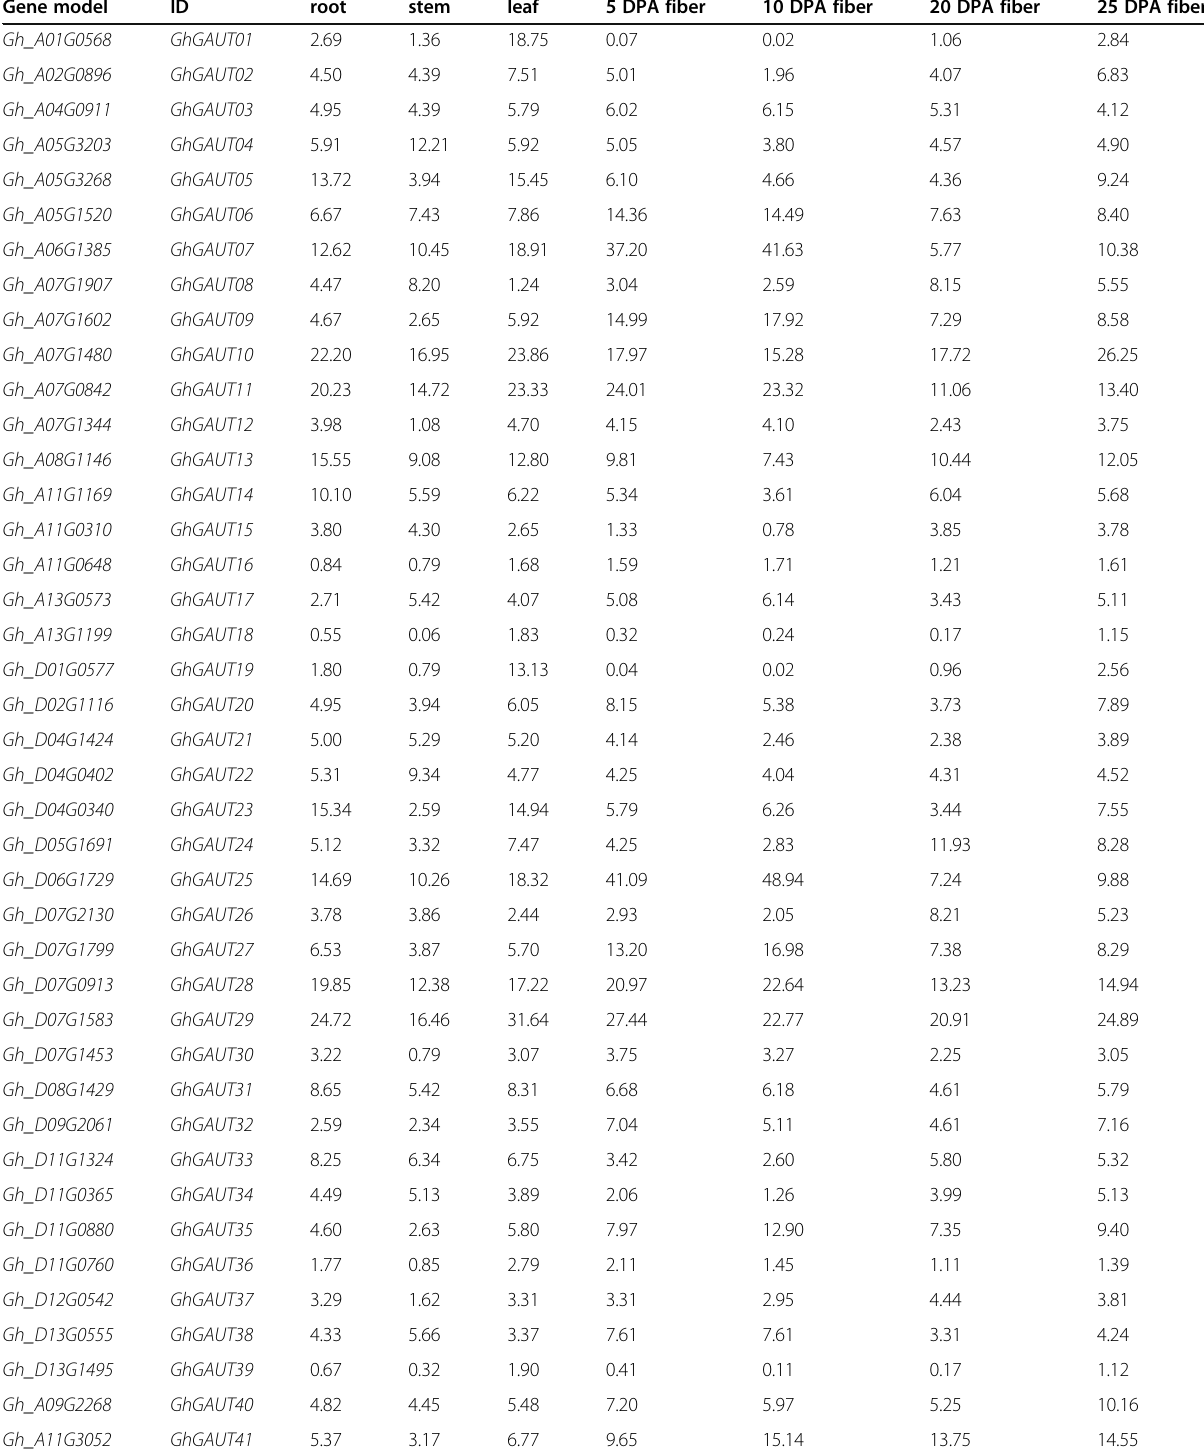
Table 5 The FPKM value of GAUT genes in G. hirsutum Gene